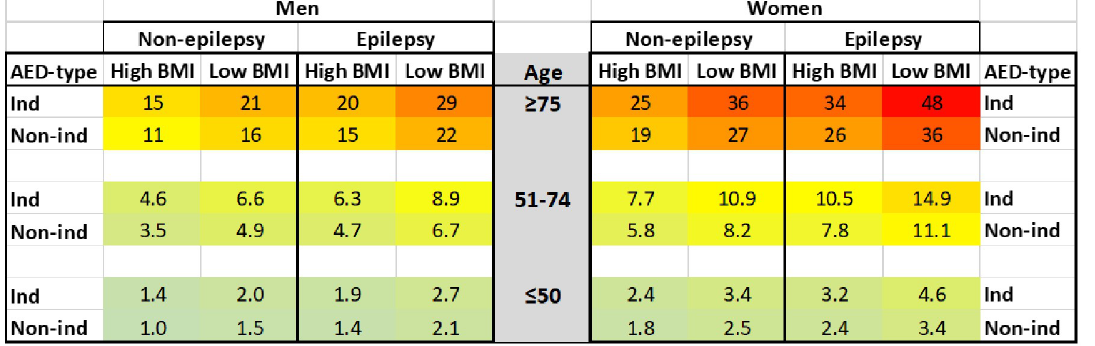
Fig 4. Chart displaying relative low energy fracture risks (as hazard rate ratios) during the follow-up period in relation to the five risk factors (gender, age, epilepsy diagnosis, type of antiepileptic drugs and BMI). Age group is the age of the patient’s first entry in the